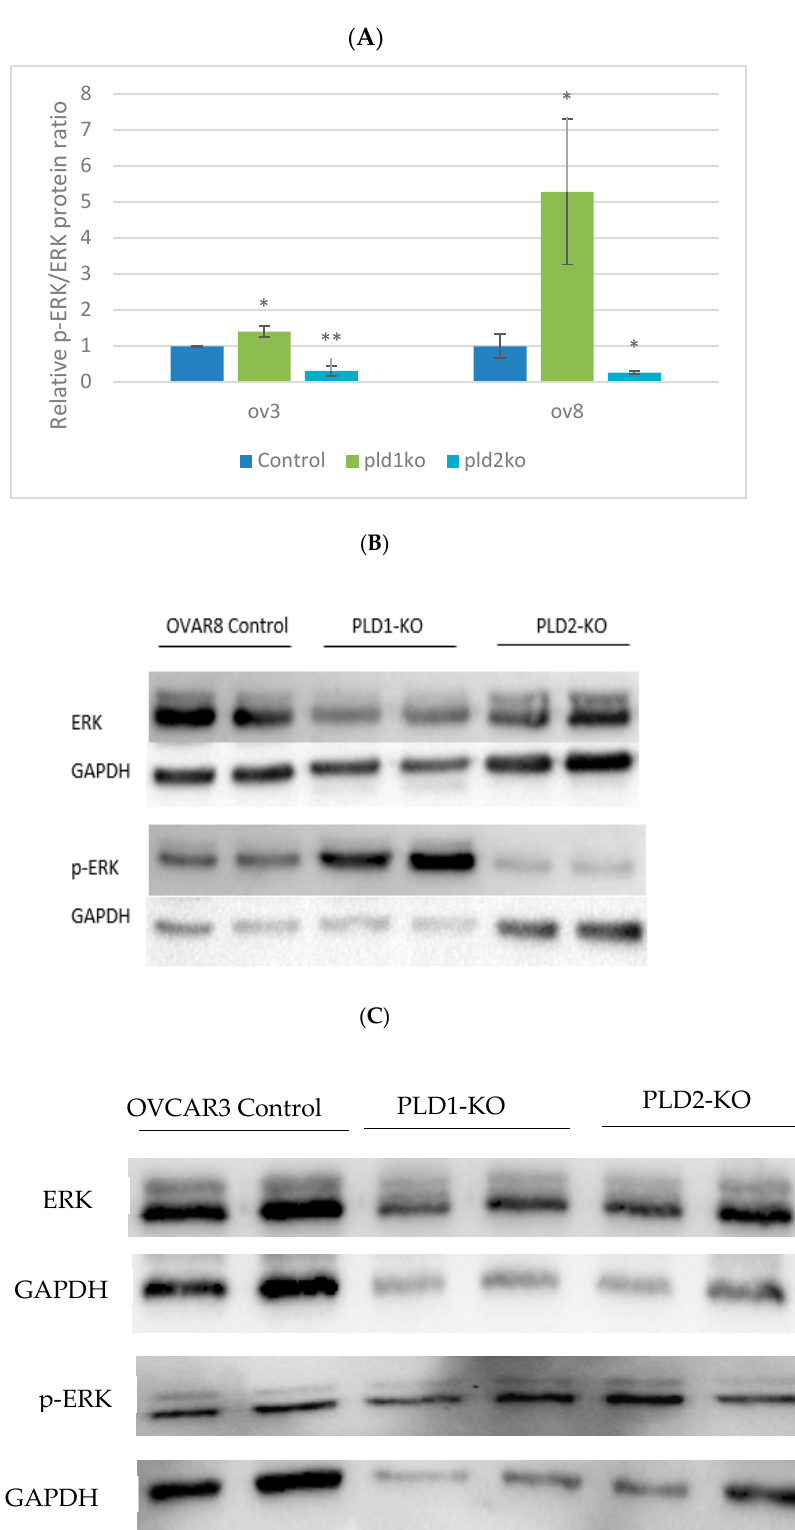
Figure 6. ERK expression is altered in PLDs KO cells. ( A ) Protein levels of p-ERK/ERK in OVCAR3 and OVCAR8 cell lines. p-ERK/ERK ratio is elevated in PLD1-KO ( p < 0.05) and decreased in PLD2-KO cells ( p < 0.05). Error bars represent SEM. ( B,C ) Representative western blot of both cell cultures is shown to demonstrate protein levels of ERK and p-ERK in control and KO cells (* p < 0.05, ** p < 0.01).